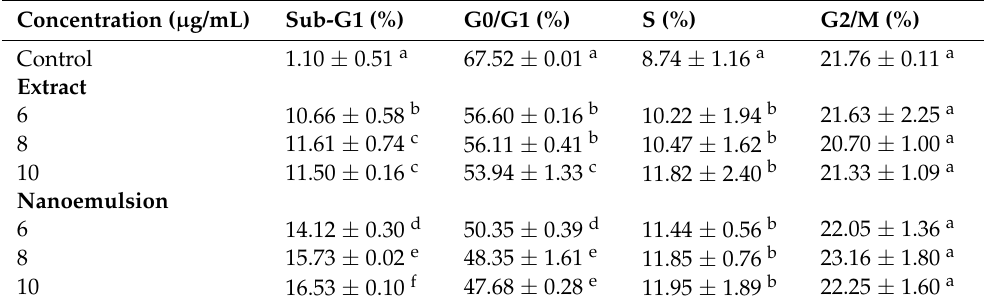
Table 5. Effect of different concentrations of xanthone extract and nanoemulsion on cell cycle distribution of liver cancer cell HepG2 a